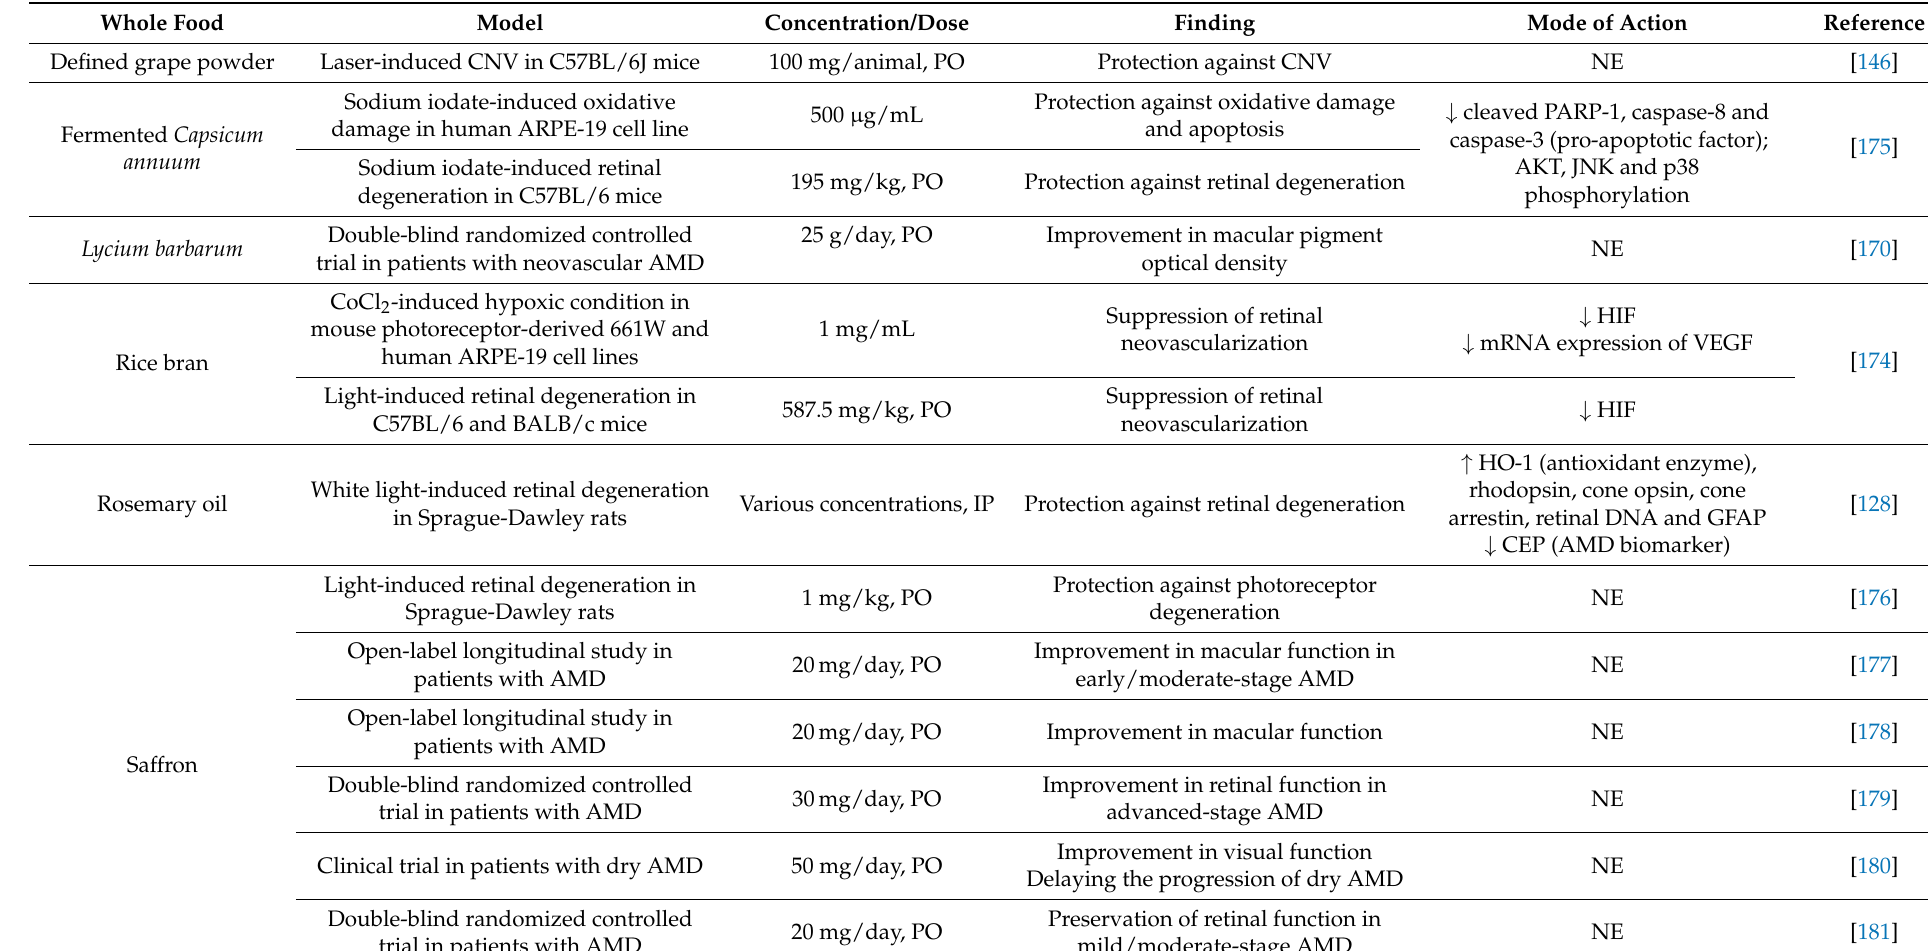
Table 7. Whole foods in the alleviation of